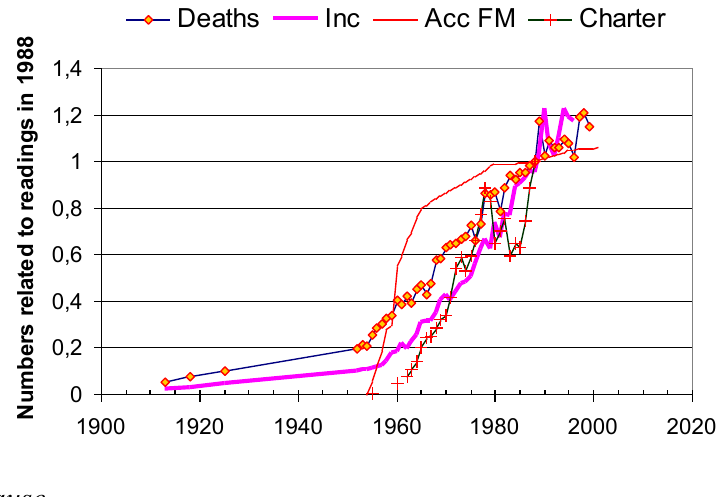
Figure 18. Charter travel, melanoma incidence and melanoma mortality start to increase from years 1962, 1958 and 1955 respectively